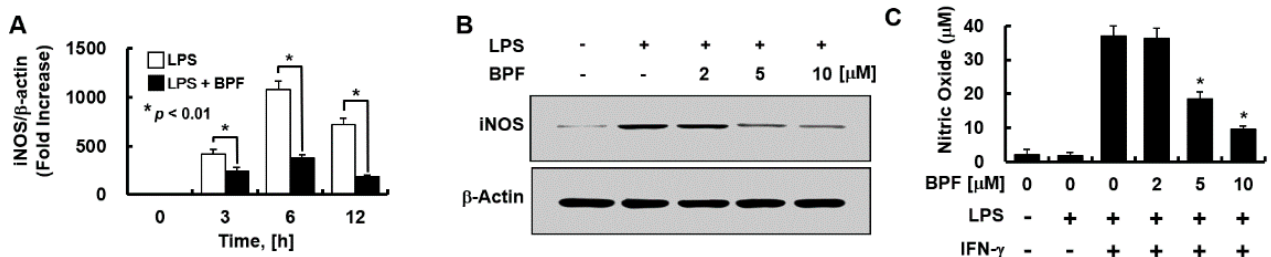
Figure 3. BPF inhibits the expression of iNOS and the production of nitric oxide in HUVECs. ( A ) HUVECs were pretreated with BPF (10 μ M for 6 h), then LPS (100 ng/mL) was added. After the indicated times, total mRNA was extracted and the expression level of iNOS and β -actin was determined using real-time PCR; ( B ) HUVECs were pretreated with the indicated concentrations of BPF for 6 h, then LPS (100 ng/mL) was added. After 24 h, the cellular protein was extracted and iNOS and β -actin levels were determined using Western blots; ( C ) HUVECs were pretreated with the indicated concentrations of BPF for 6 h, then LPS (100 ng/mL) and IFN- γ (200 ng/mL) were added under the indicated conditions. After 24 h, the cell culture supernatant was harvested, and nitric oxide levels were determined using the Griess reaction assay ( A , C ). All results are shown as means ± SD of three different experiments with triple samples. * p < 0.5 compared to LPS + IFN- γ ( C ); ( B ) The results are from one representative experiment of three independent experiments.